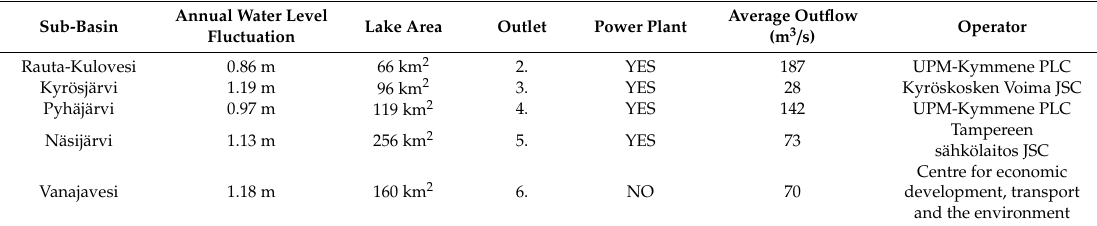
Table 1. The most important regulated lakes of the Kokemäenjoki watershed, source: Finnish Environment Institute, 2016 [70].